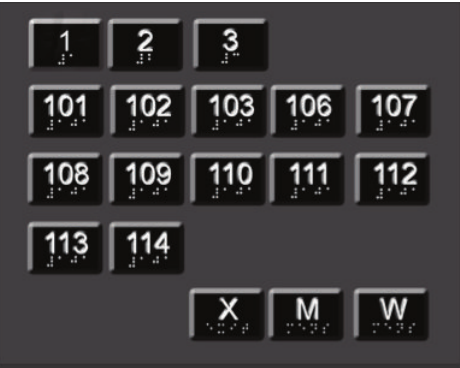
Figure 2: Kiosk design.